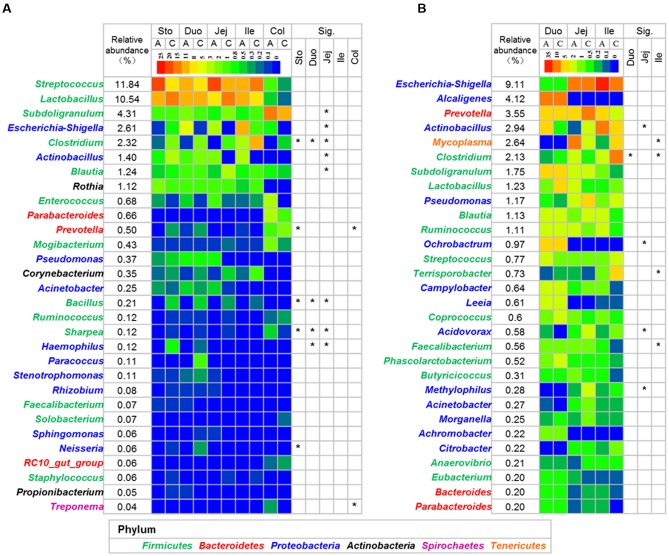
Heatmap of the dominant genus in lumen (A) and mucosa (B). The mean relative abundance was calculated using all the samples in control and antibiotic group. Asterisks indicate different in the antibiotic group from the control group (Mann–Whitney U-test with and a false discovery rate < 5%). See Supplementary Tables S4, S5 for the complete dataset. Abbreviations: A, antibiotics; C, control; Col, colon; Duo, duodenum; Ile, ileum; Jej, jejunum; Sto, stomach.